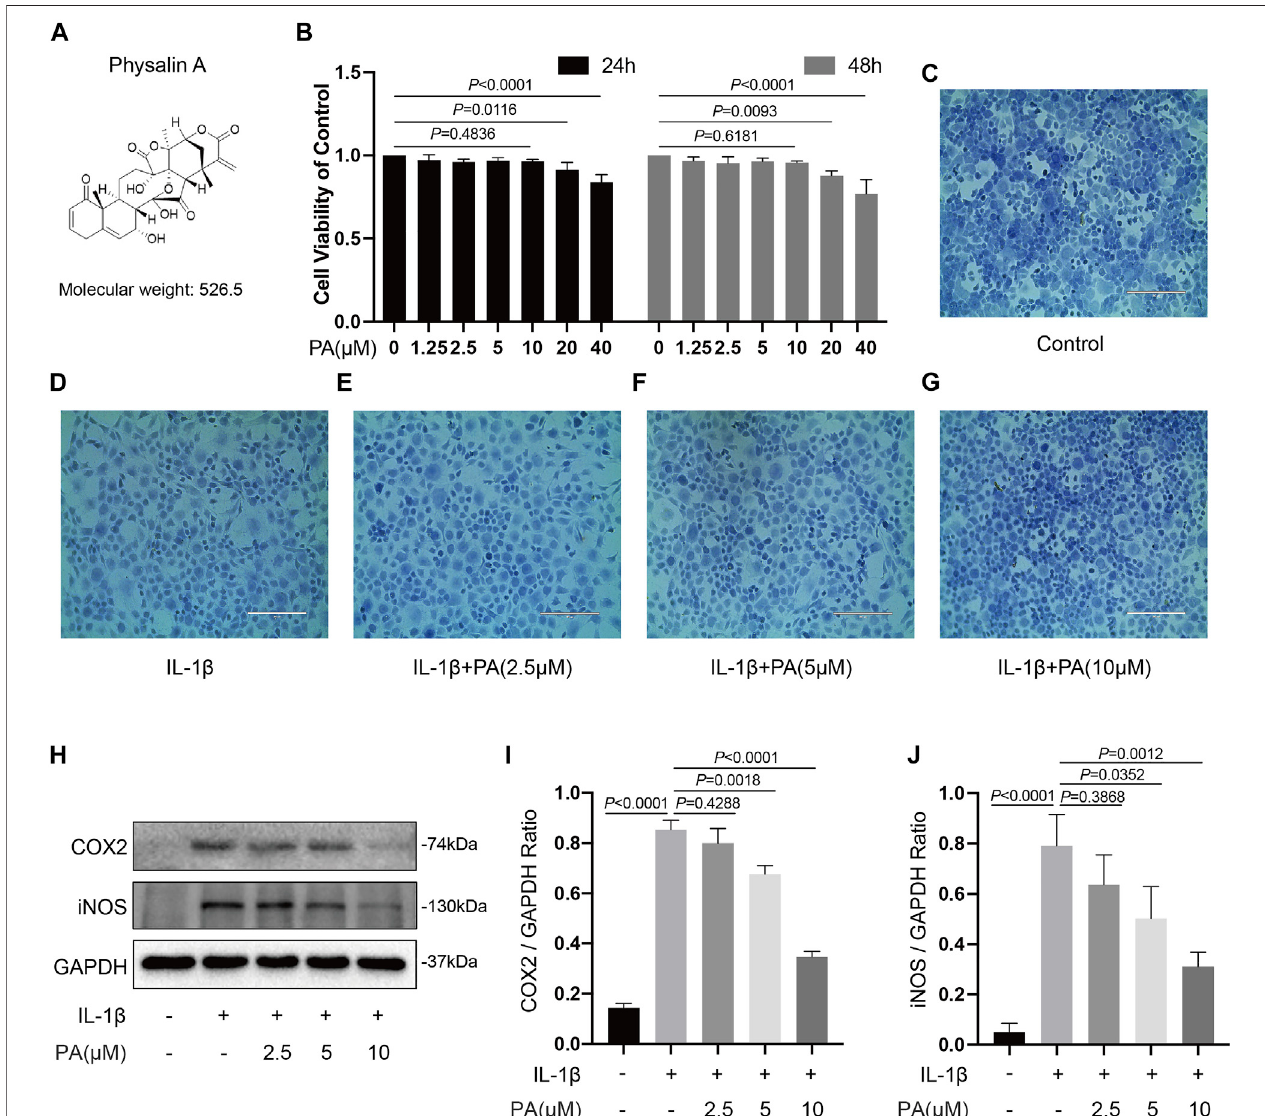
FIGURE2| EffectsofPAoncellviabilityand PAsuppressed in fl ammatoryresponsesinducedbyIL-1 β . (A) Molecularstructure ofPA. (B) Mice chondrocytes were treatedwithPA(0,1.25,2.5,5,10,20,and40 μ M)for24and48 h,andcellviabilitywasdetectedwithaCCK-8kit. (C – G) Toluidinebluestainingofchondrocytestreated with IL-1 β (5 ng/ml) and PA for 24 h (scale bar 200 μ m). (H) Western blotting results and (I,J) quantitative analysis of COX2 and iNOS in IL-1 β – induced chondrocytes treated with PA. GAPDH was used as an internal reference. Data are presented as means ± SD ( n (cid:1) 3). The exact p value was marked in the corresponding fi gure and p < 0.05 was considered statistically signi fi